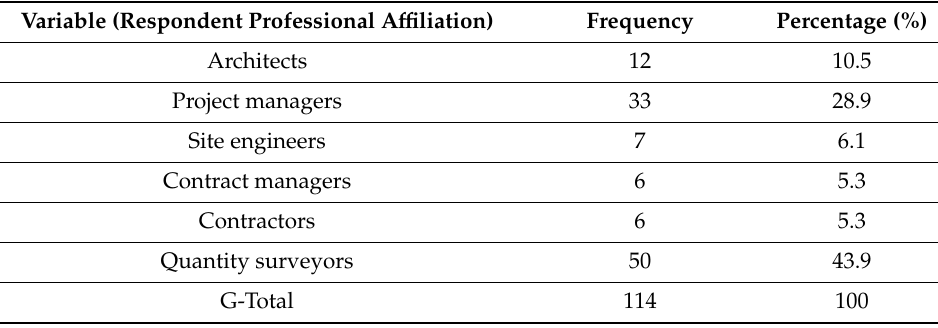
Table 1. Tabularised illustration of respondents’ professional a ffi liation.